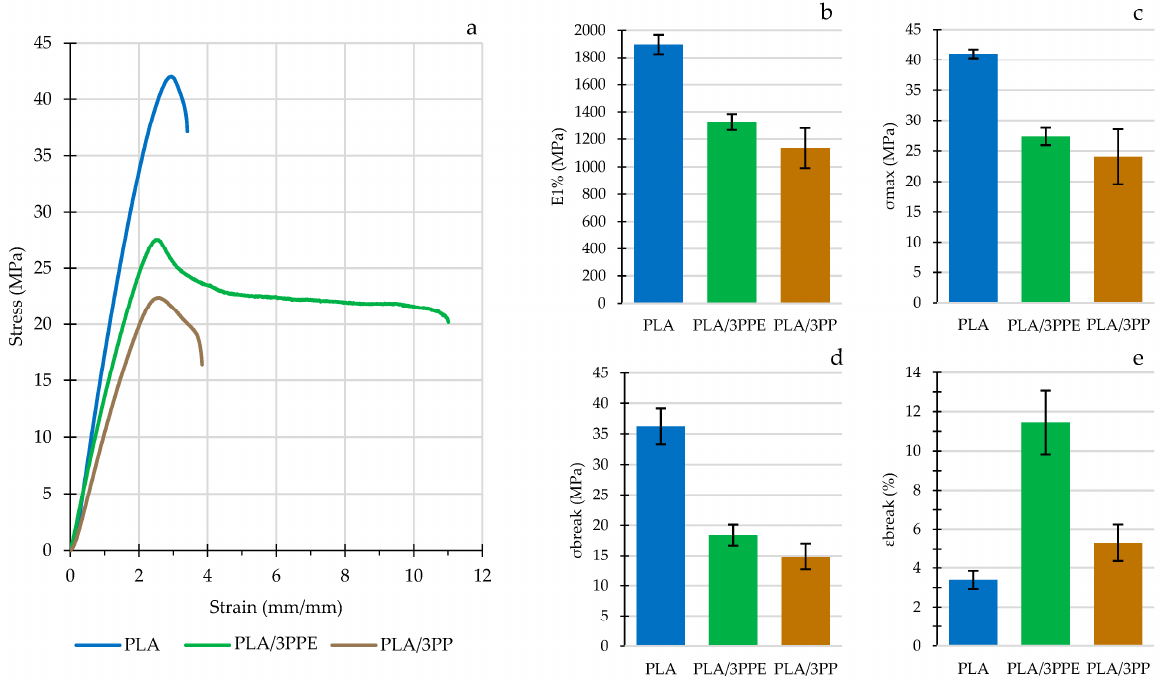
Figure 3. Representative stress vs. strain curves of PLA, PLA/3PPE, and PLA/3PP in MD ( a ) and respective mechanical indexes ( b – e ).